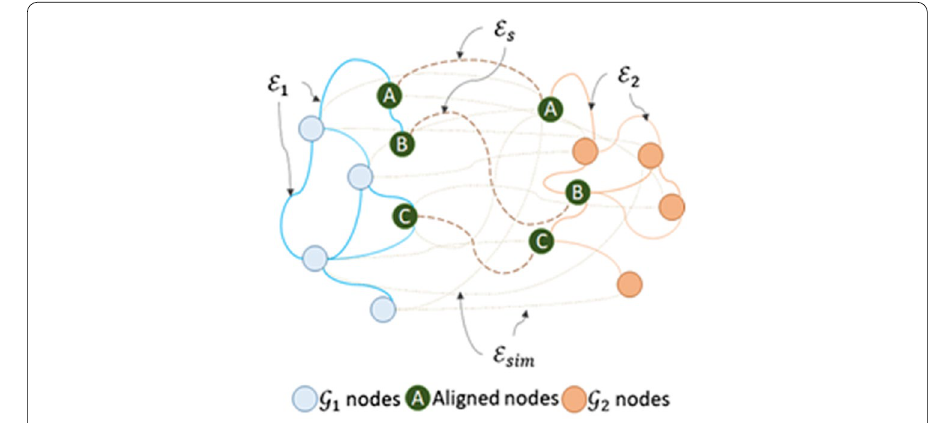
Fig. 3 Expanded graph—Final